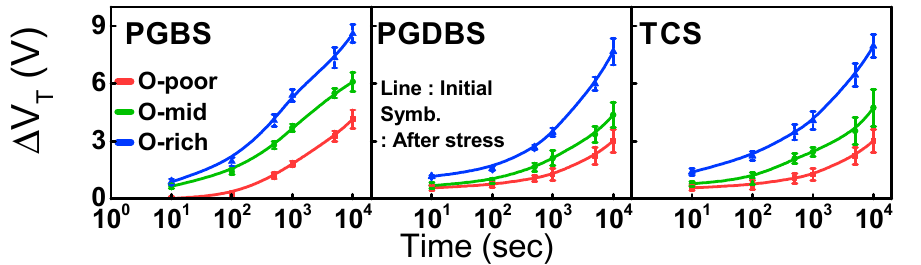
Figure 5. Δ V T for various O-contents as stress time under PGBS, PGDBS, and TCS.